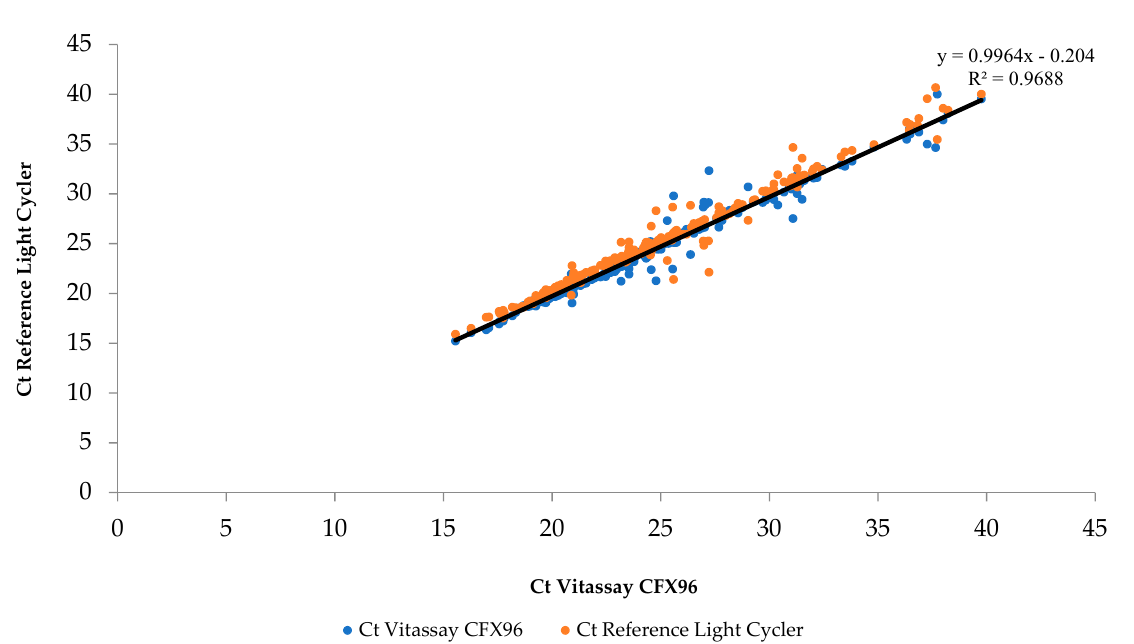
Figure 1. Comparative of the Ct values of the Vitassay CFX96 TM versus the reference Light Cycler. The Ct values of EC included in each reaction were constant, which made it possible to validate the performance and reproducibility of the Vitassay qPCR Malaria 5 test.